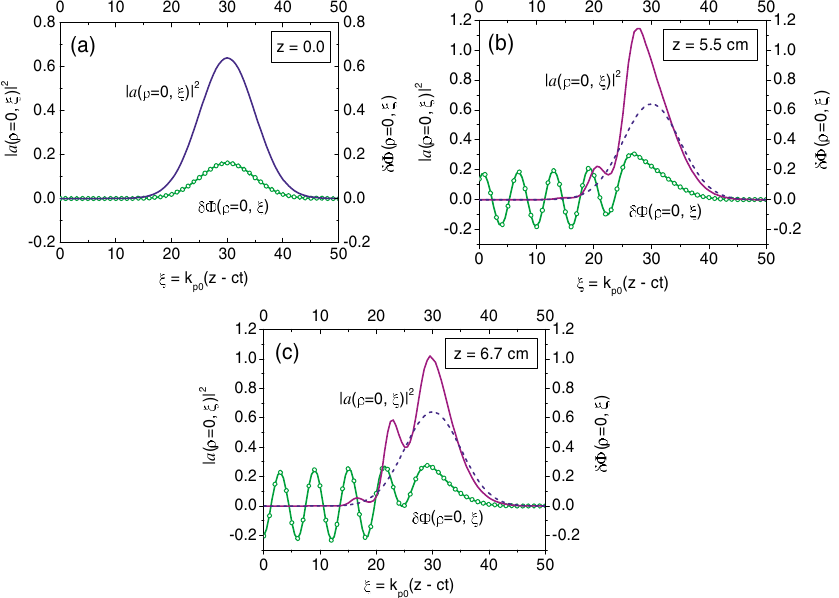
FIG. 2. (Color) The normalized laser pulse intensity on axis j a (cid:8) r (cid:5) 0 ; (cid:31) (cid:9)j 2 and wakefield potential , (cid:25) (cid:5) (cid:25) (cid:8) r (cid:5) 0 ; (cid:31) (cid:9) (cid:2) 1 (lines marked by circles) at propagation distances (a) z (cid:5) 0 , (b) z (cid:5) 5 : 5 cm , and (c) z (cid:5) 6 : 7 cm . The parameters are the same as in Fig.